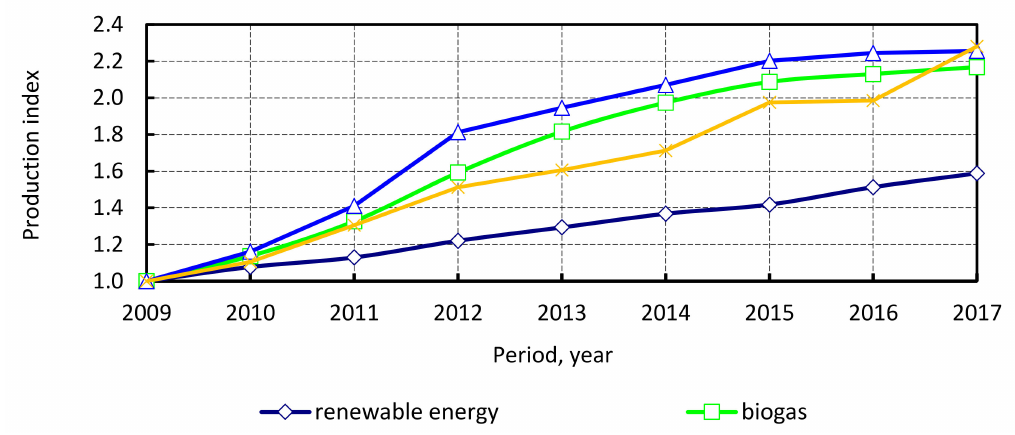
Figure 1. Production index.